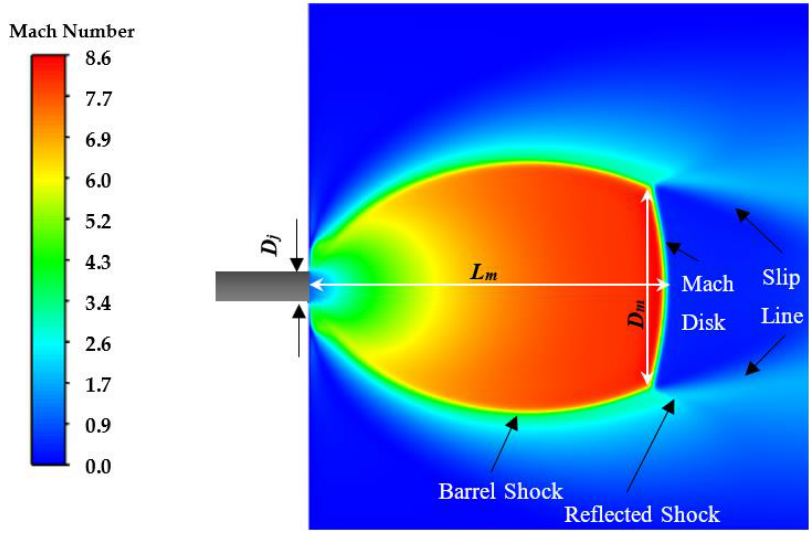
Figure 6. Contour of a highly under-expanded jet and barrel shock.